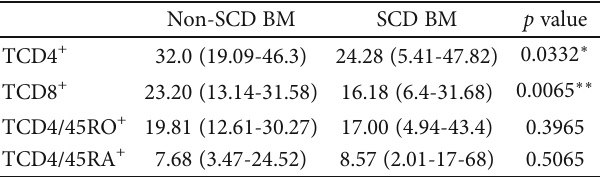
Table 4: Lymphocyte frequencies (%) in